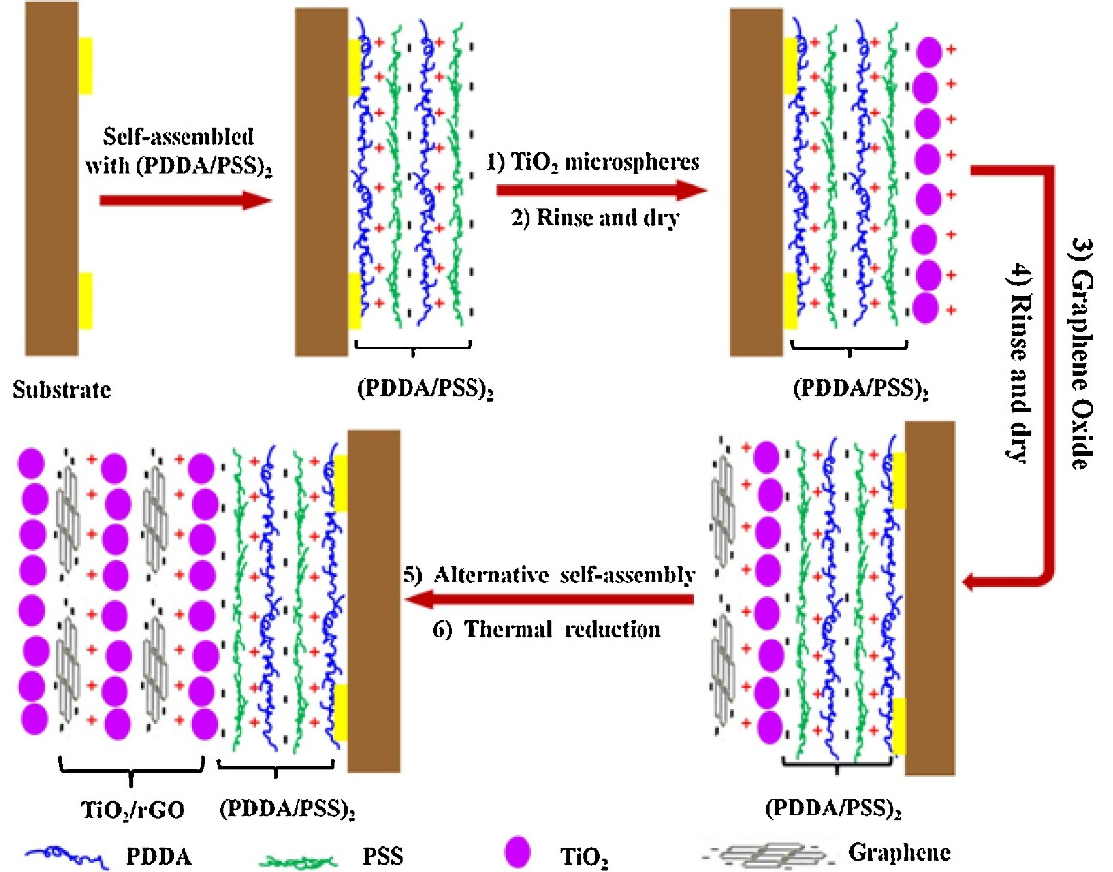
Figure 11. Fabrication illustration of TiO 2 /rGO multilayer hybrid film by layer-by-layer self-assembly. Reprinted with permission from Ref. [178]. Copyright 2017 Elsevier.